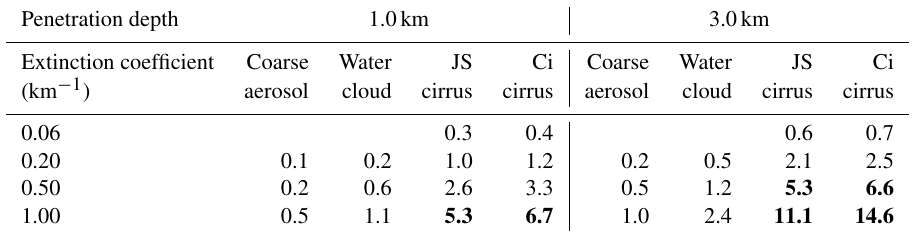
Table 5. Multiple-scattering contribution to lidar signals in per cent (%) of the single scattering. The distance to the cloud base is 1km; the lidar RFOV is 0.25mrad. Values exceeding 5% threshold are in bold